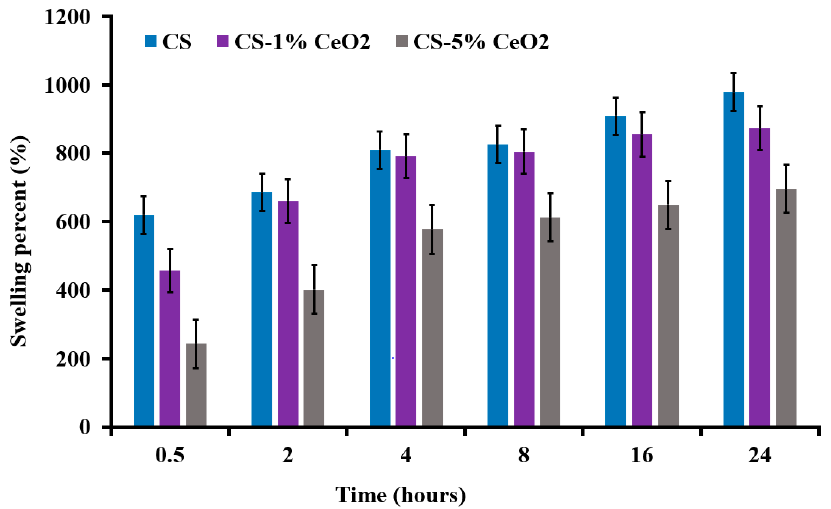
Figure 7. Demonstration of the swelling percent of the chitosan-based hydrogel